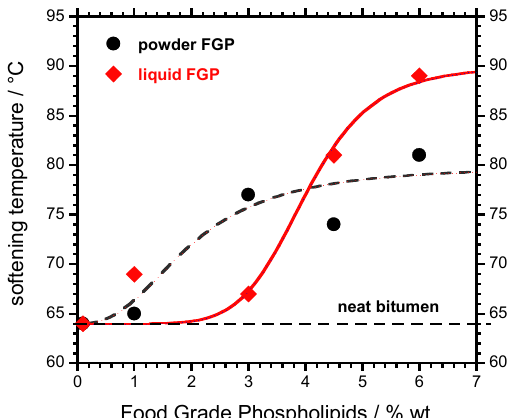
Figure 4. Softening temperature as a function of Food Grade Phospholipid (FGP) content in hot bitumen. FGP added as solid powder (circles) or as liquid dispersion (rhombus). Reproduced with permission from [54], Elsevier,